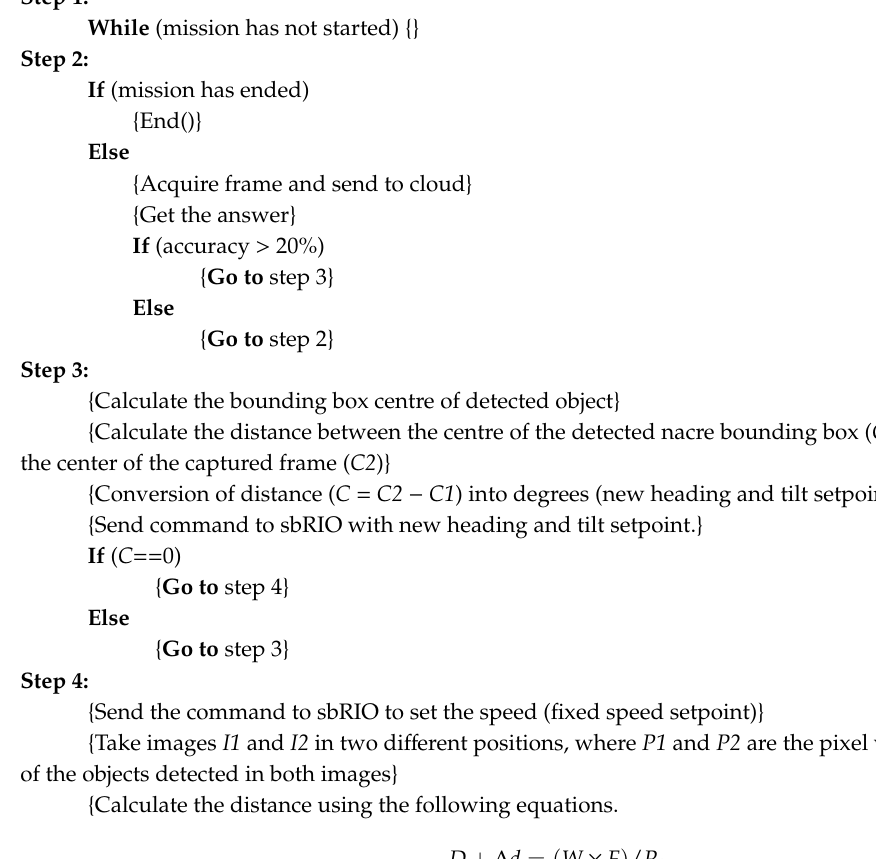
Algorithm 1. Specimen tracking